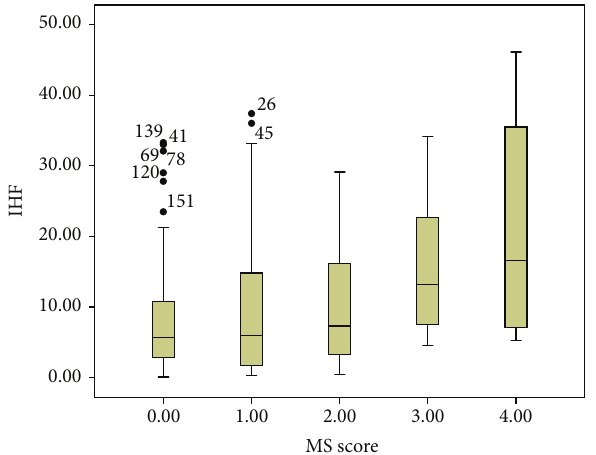
Figure 4: Boxplots of IHF with respect to MS score. The lower boundary of the box and whisker plot corresponds to the 25th percentile, the line within the box corresponds to the median, and the upper boundary of the box corresponds to the 75th percentile. The whiskers extend to the most extreme data point, which is no more than 1.5 times the interquartile range from the